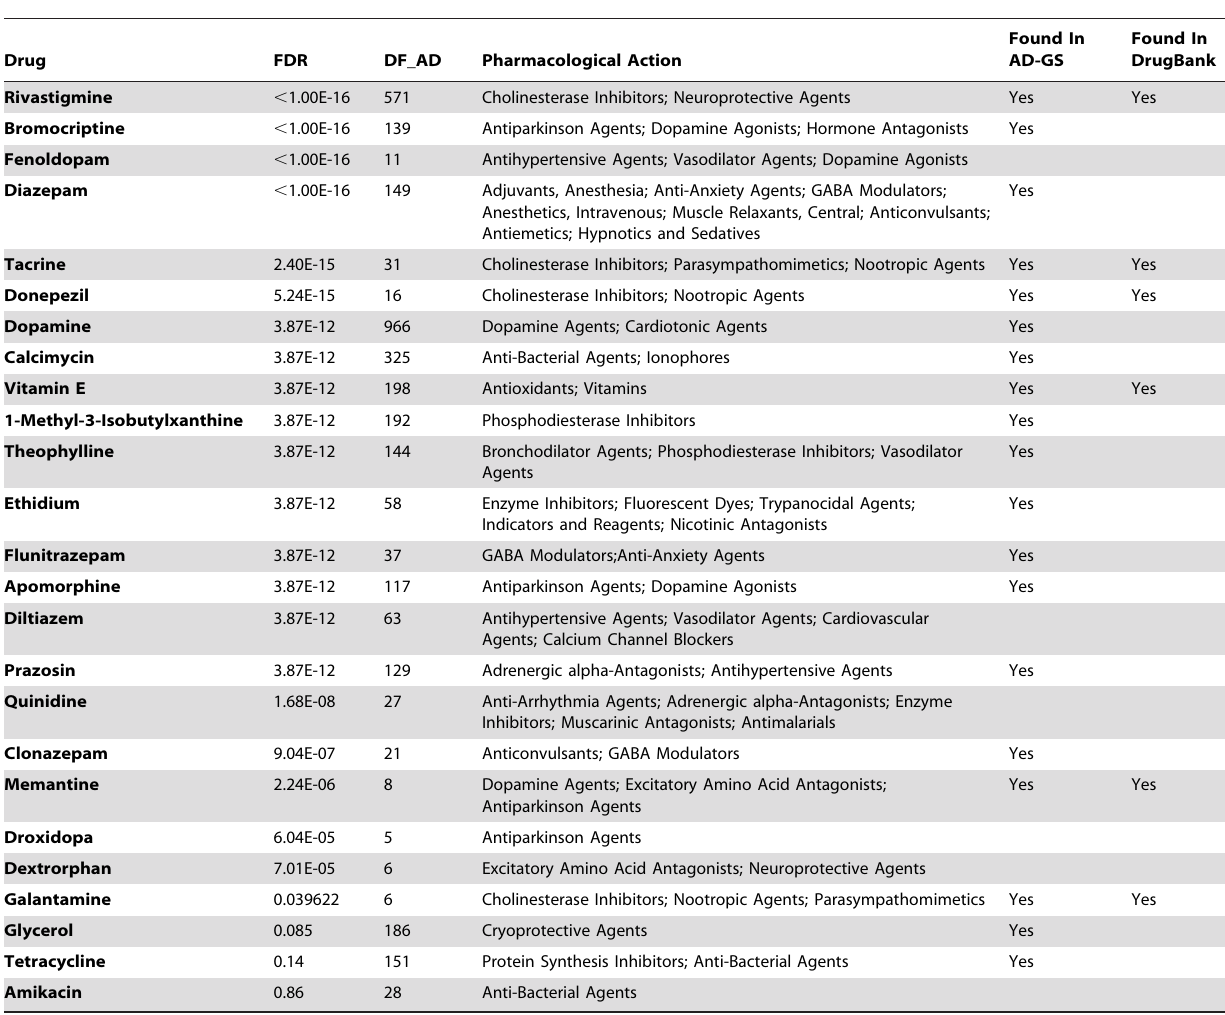
Table 2. A representative sample of enriched AD